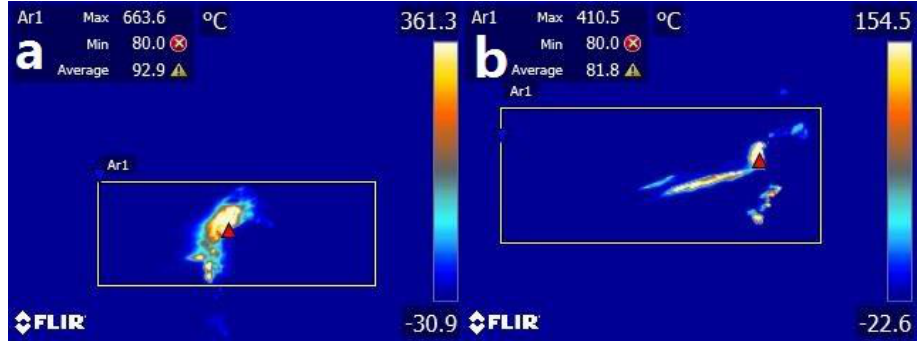
Figure 4. Comparison of cutting temperatures between (a) ATCN-C10 and (b) ATCN-C@10 ceramic tools (test conditions: depth of cut α p = 0.2 mm, feed rates f = 0.102 mm / r, cutting speed υ = 300 m / min).